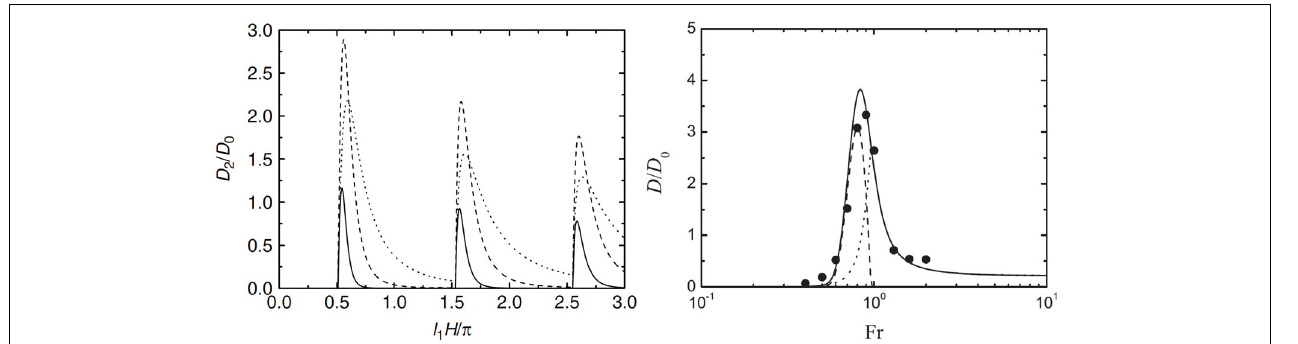
FIGURE 11 | Left: trapped lee wave drag (here denoted by D 2 ) normalized by (30) as a function of l 1 H /π . Solid line: l 1 a = 10, dashed line: l 1 a = 5, dotted line: l 1 a = 2. Reproduced from Figure 6 of Teixeira et al. [111]. Copyright © 2012 Royal Meteorological Society. Right: Drag normalized by (30) as a